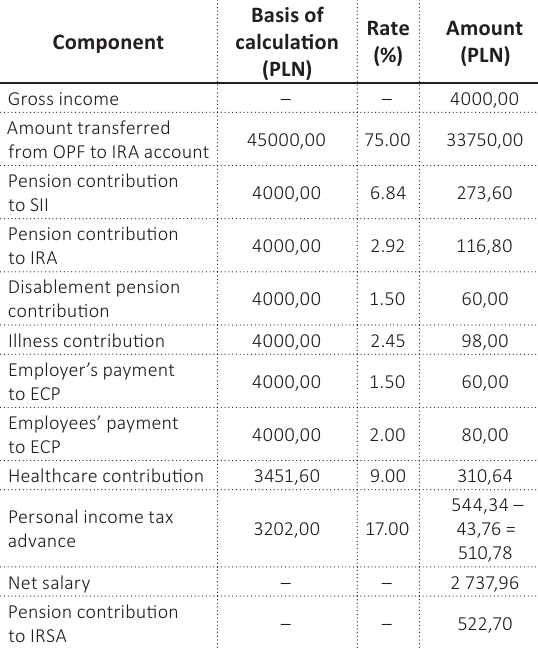
Table 5. Variant 1 – participation in ECP and non-member of IRA